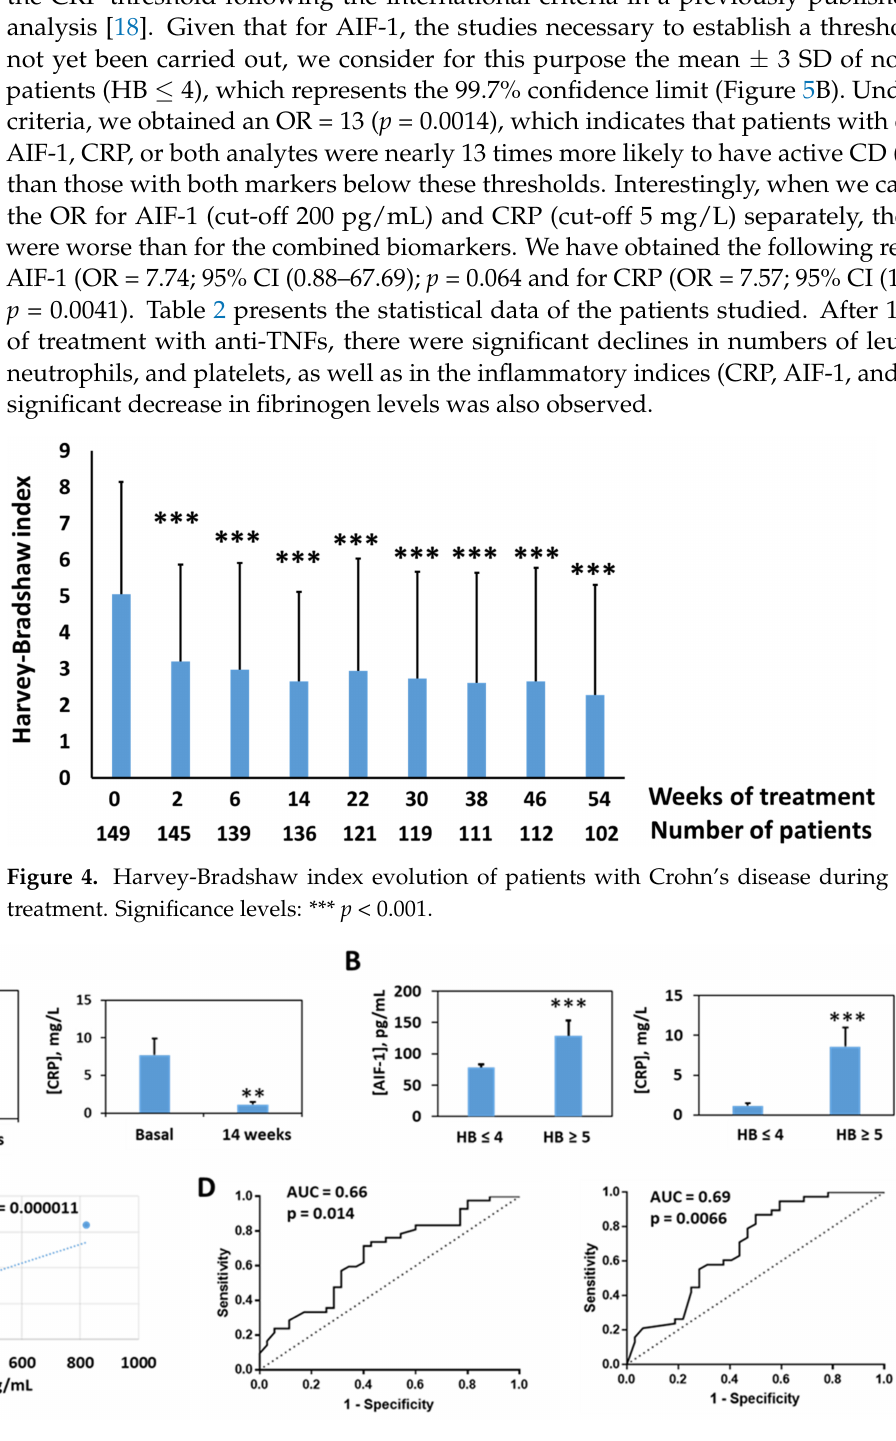
Figure 5. Comparison of serum AIF-1 and CRP levels in Crohn’s disease patients. ( A ) Levels of both markers in serum at baseline and at 14 weeks of anti-TNF α treatment. The mean ± SEM is shown. ( B ) Comparison of the levels of both serum markers between inactive (HB ≤ 4) and active (HB ≥ 5) patients. The mean ± SEM is shown. ( C ) Correlation between serum AIF-1 levels and the HB index of patients with Crohn’s disease. ( D ) ROC curves for AIF-1 ( left ) and CRP ( right ). Significance levels: * p < 0.05; ** p < 0.01; *** p <